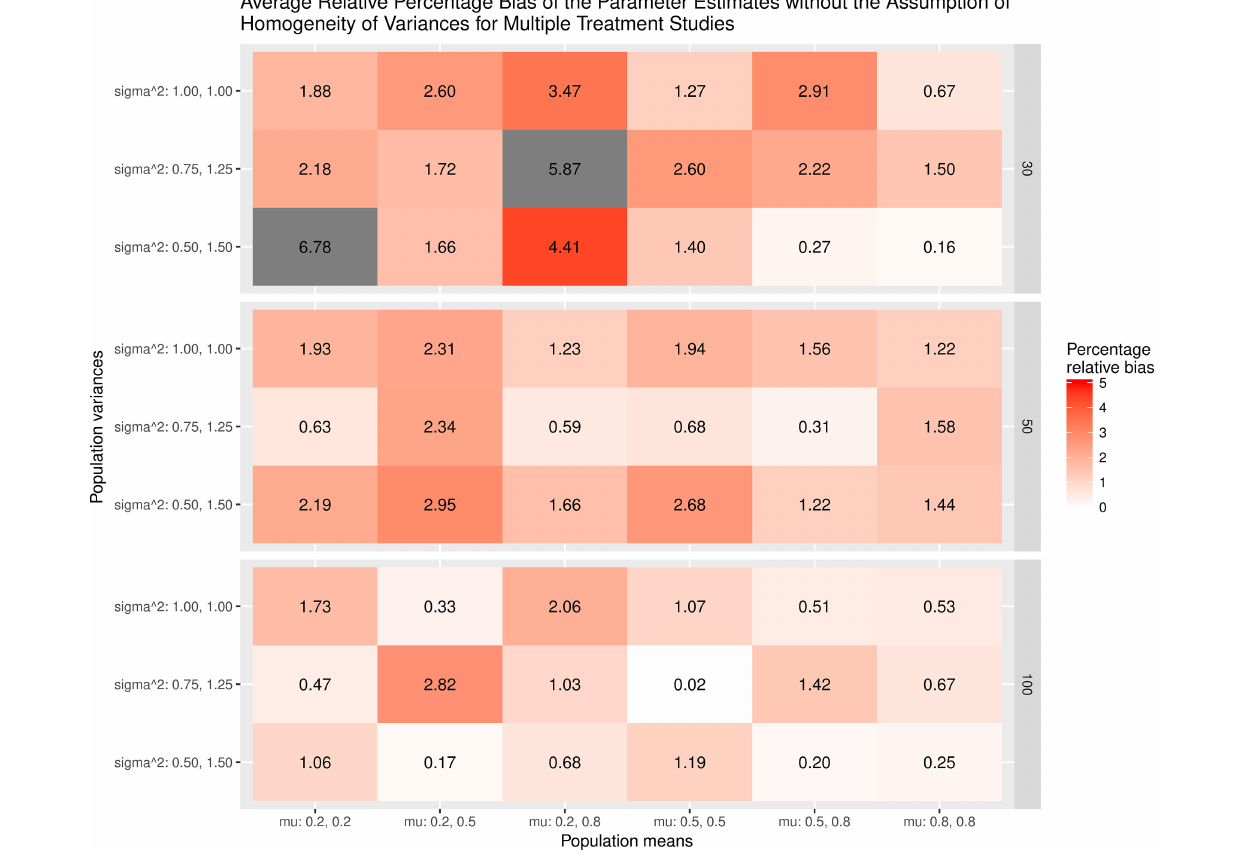
Frontiers in Psychology |